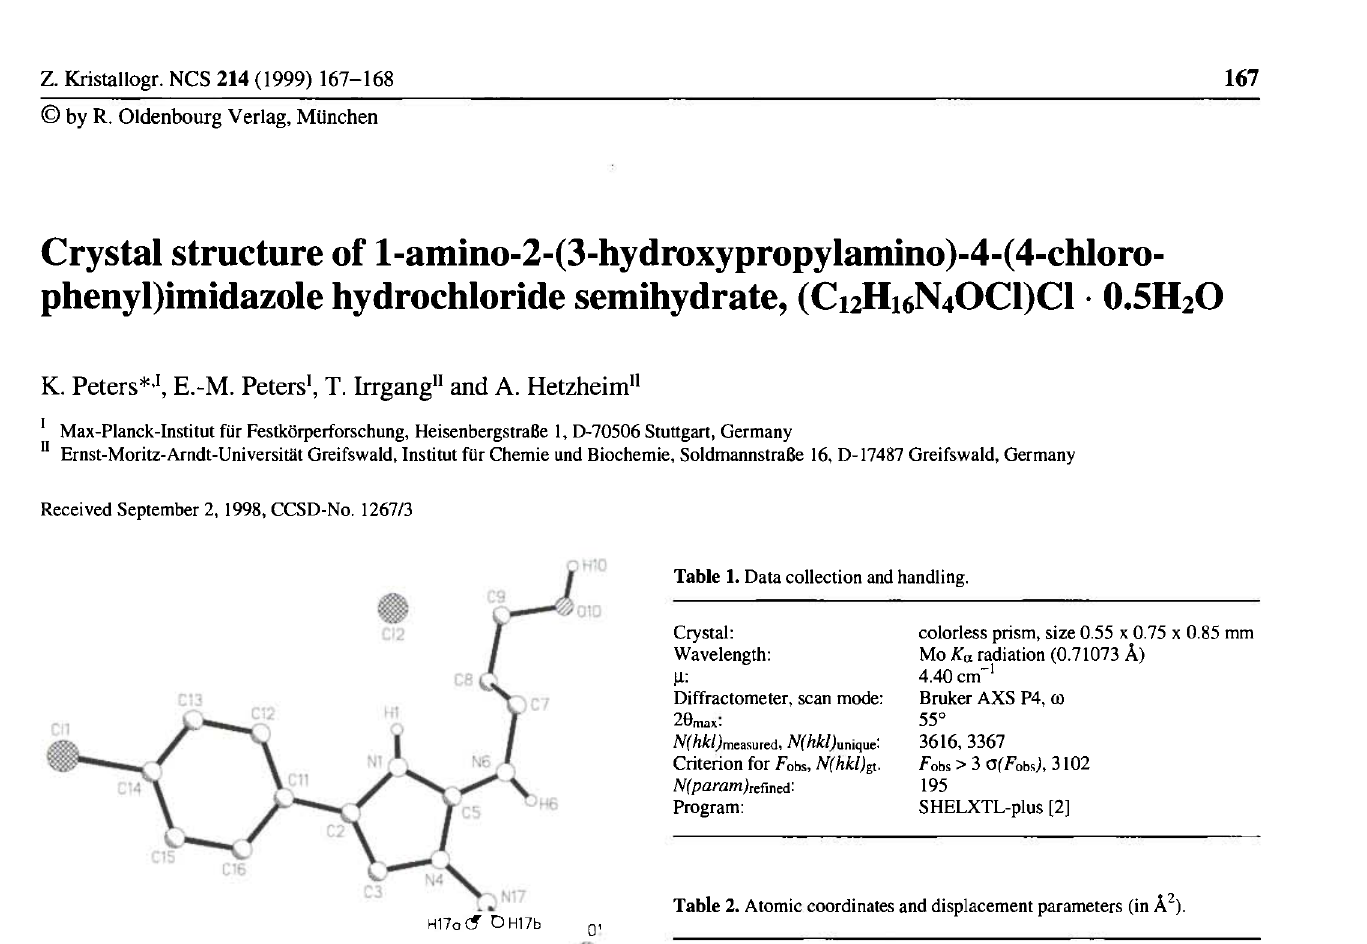
Table 2. Atomic coordinates and displacement parameters (in Ä 2 ).